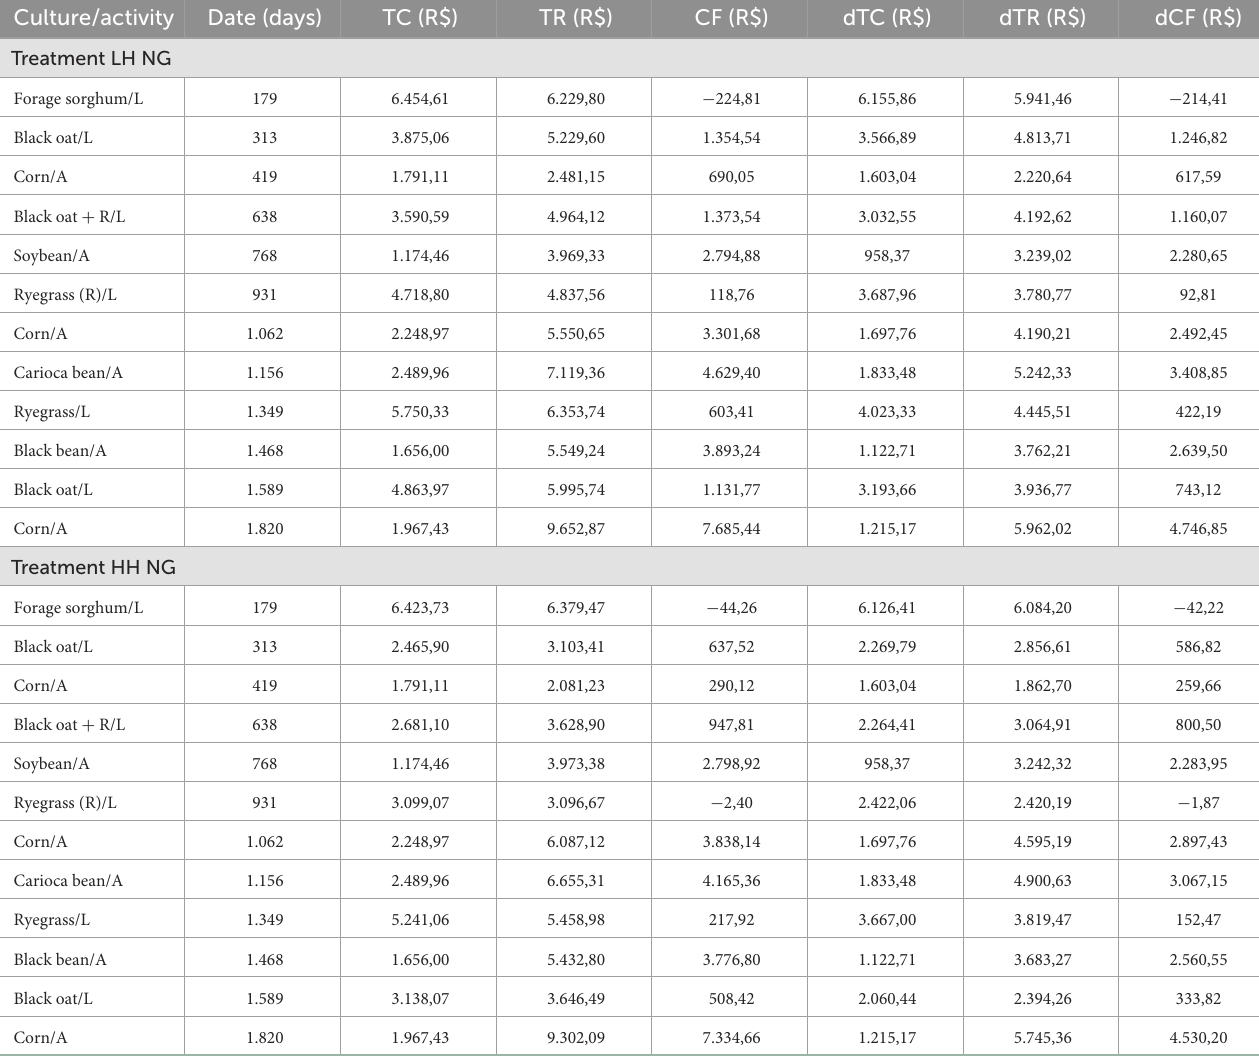
TABLE 4 Total cost (TC), total revenue (RT), and cash flow (FC) for treatments that received nitrogen fertilization in the field in the ICLS for 5.5 years.